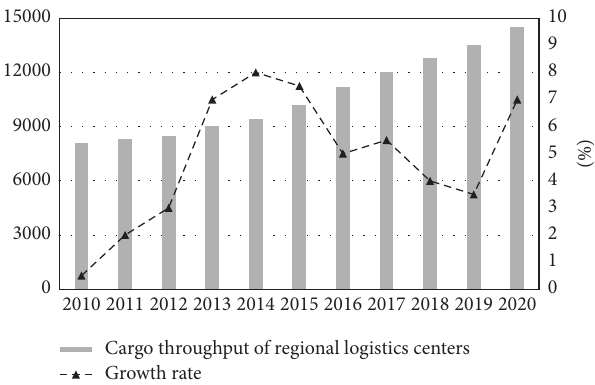
Figure 1: Cargo throughput and its growth rate at regional logistics